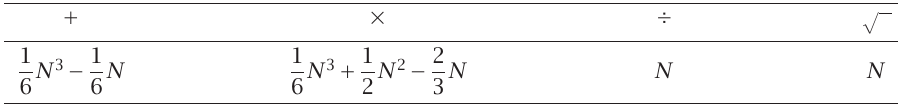
Table 2.2 . Operation counts for computing L